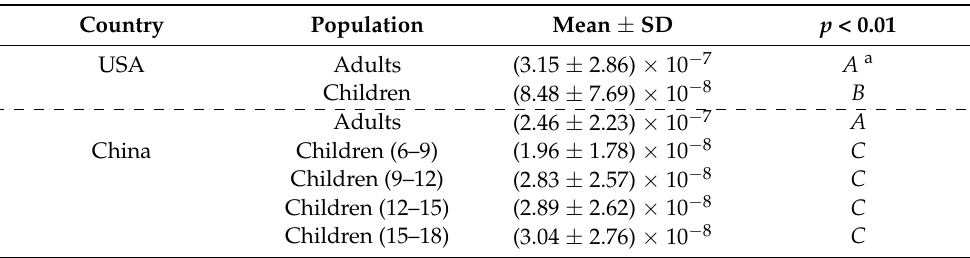
Table 6. The analysis of variance and multiple comparisons among the total cancer risks calculated using Model I based on age ( n =